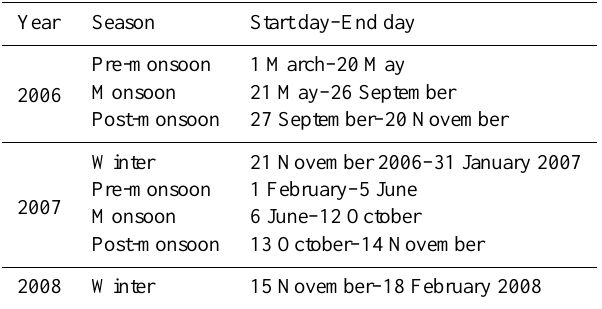
Table 1. Identification of seasonal transitions as a function of the local weather